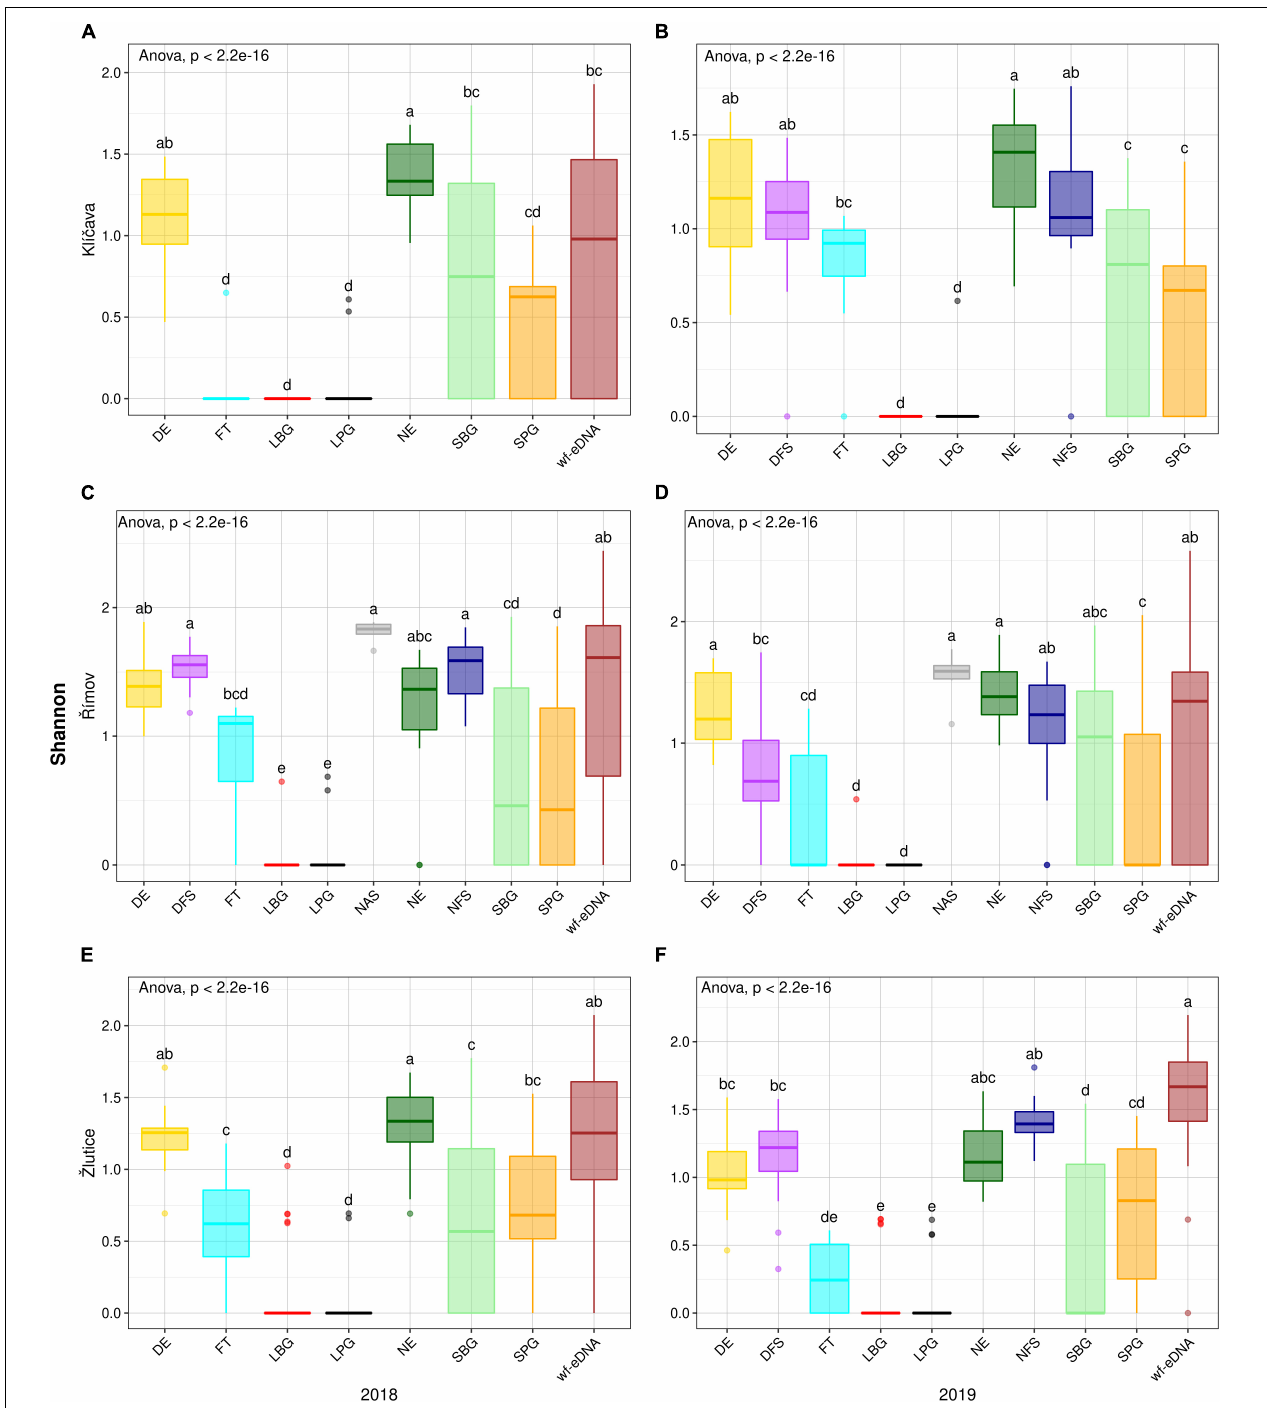
FIGURE 3 | Box plots comparison of alpha diversity (Shannon) based on BPUE data in 2018 (left plots) and 2019 (right plots) between wf-eDNA assay and traditional sampling methods in Klíˇcava, ˇRímov and Žlutice reservoirs. Significant differences are indicated by different upper superscripts. Horizontal line inside the box indicates the calculated median, box 1st and 3rd quartile, whiskers data range and dots outliers of Shannon value. Traditional sampling methods are abbreviated aS follow: DE = day electrofishing, NE = night electrofishing, SBG = standard benthic gillnets, SPG = standard pelagic gillnets, LBG = large mesh-size benthic gillnets, LPG = large mesh-size pelagic gillnets, NAS = night-time adult seining, DFS = day-time fry seining, NFS= night-time fry seining, FT = fry trawl and wf-eDNA = eDNA from water targeting fish.